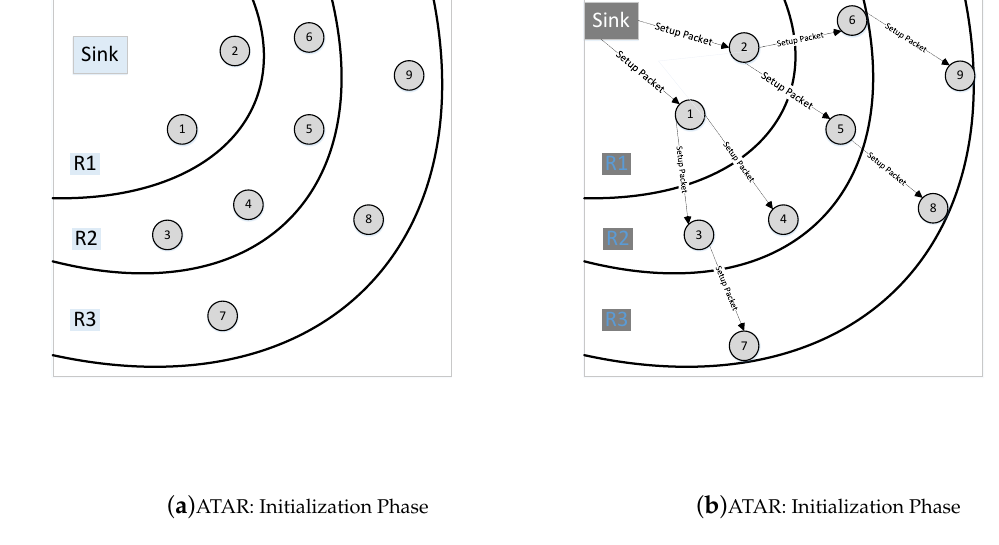
Figure 9. ATAR: Initialization